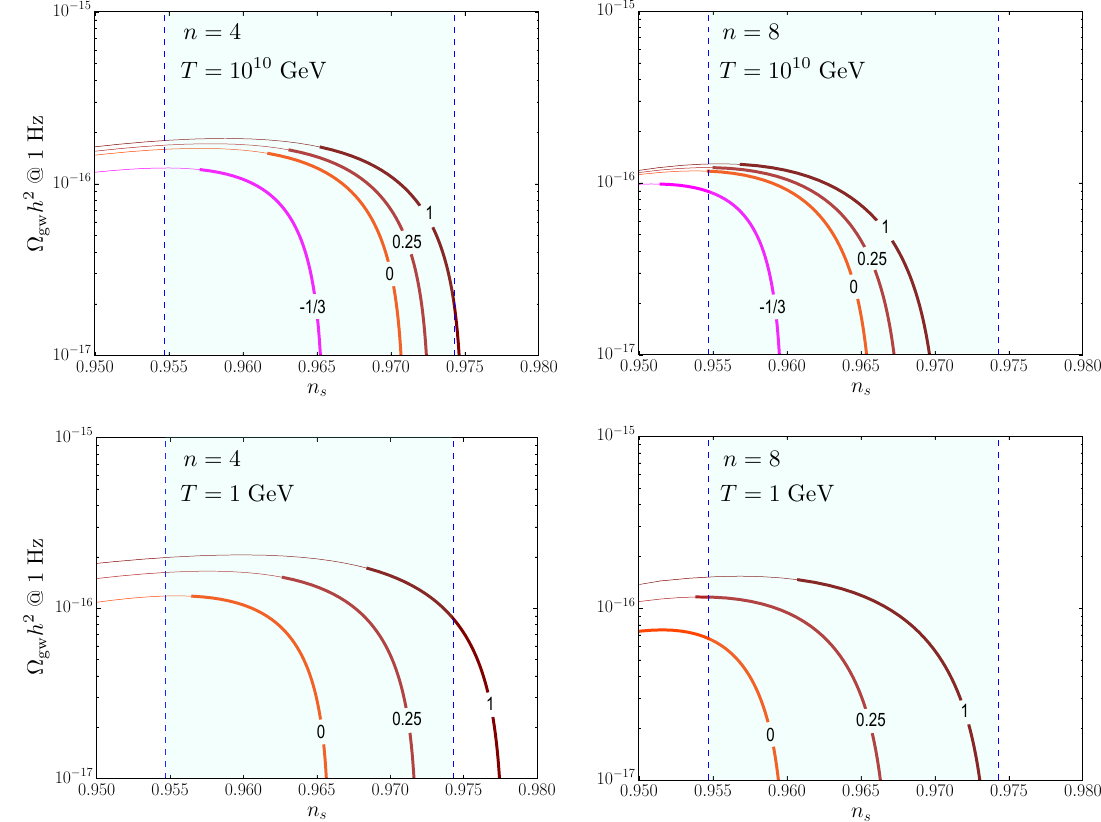
Figure 4. The amplitude of inflationary gravitational waves, Ω gw h 2 measured at 1 Hz (Equation (25)) plotted against n s , for the GG model with n = 4 and 8, and T reh = 1 and 10 10 GeV. The shaded region is the 2 σ constraint on n s from Planck. Various curves in each panel correspond to the values of ¯ w as before. The thick part of each line corresponds to where r < 0.07 [41]. In the lower panels, we omit the ¯ w = − 1/3 curves as they are already ruled out by the constraint on n s .